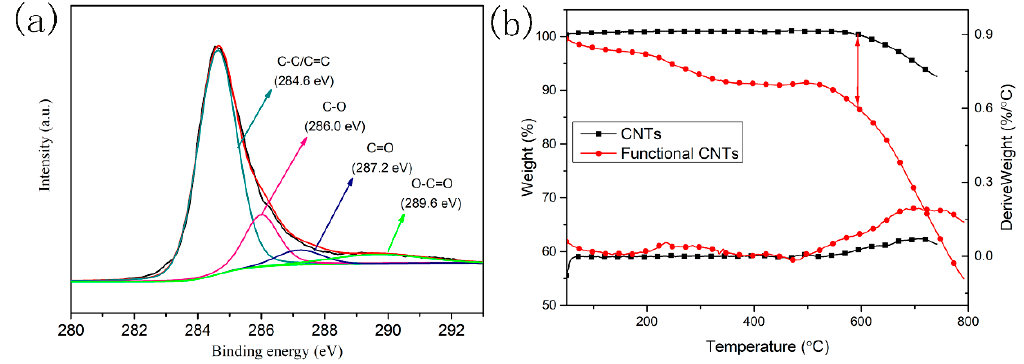
Figure 2. ( a ) XPS spectra and ( b ) TGA curves of f -CNTs.